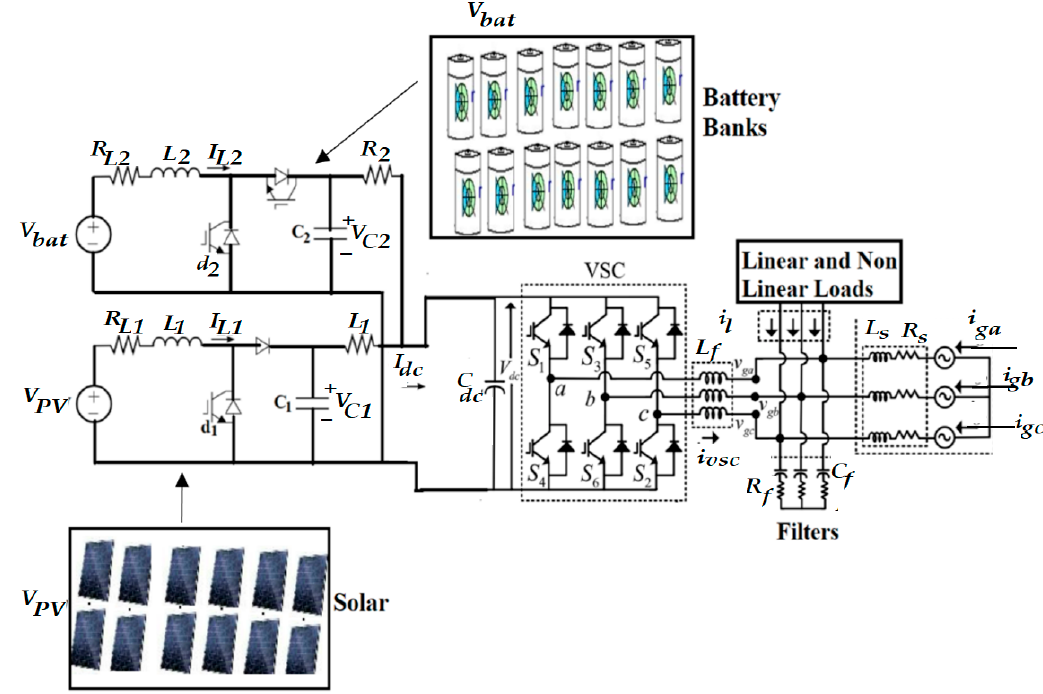
Figure 9. Proposed Equivalent Circuit for DUT Microgrid.